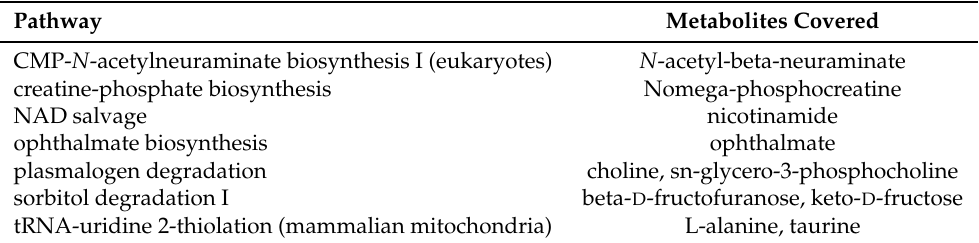
Table A5. ST000741, Pathway Covering Using Constant Cost Function.